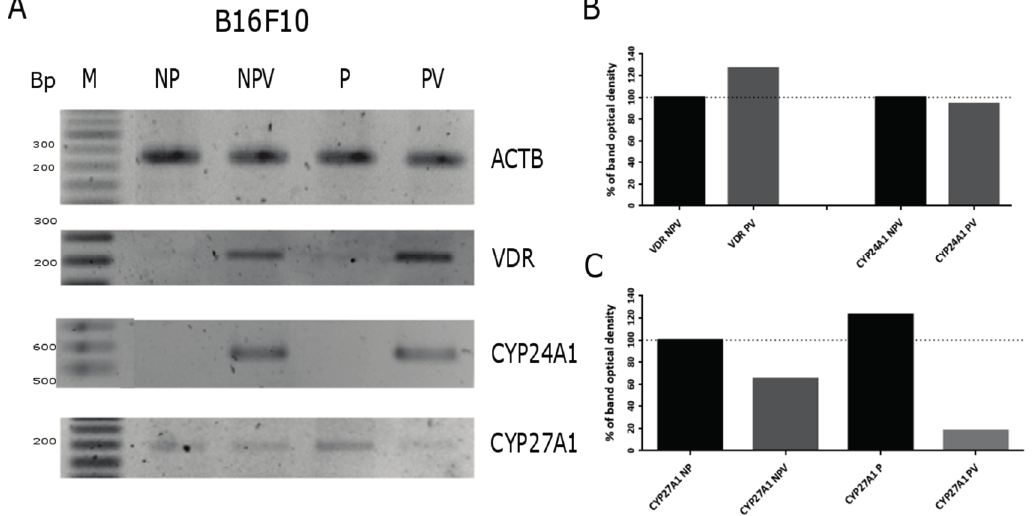
Figure 6. Melanogenesis and 1,25(OH) 2 D 3 modulate VDR, CYP24A1 and CYP27A1